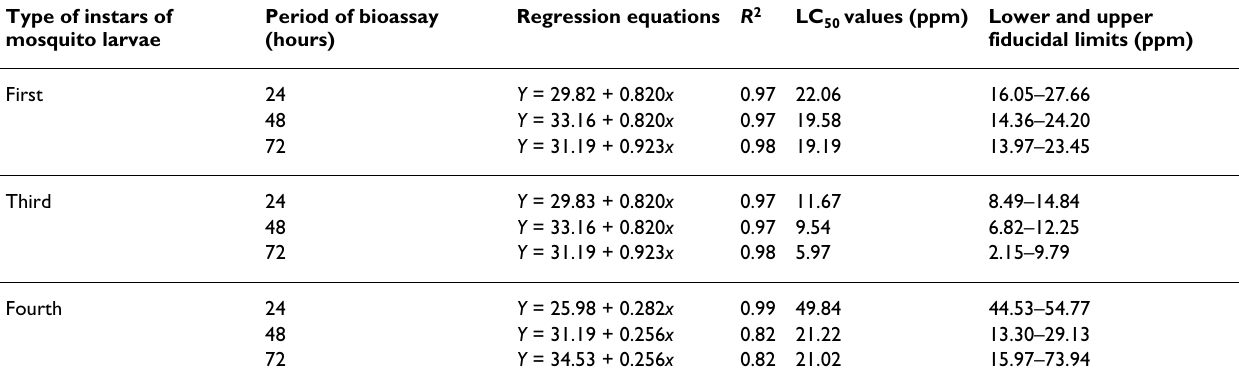
Table 4: Log probit analysis of the larvicidal activity of chloroform:methanol extract of the green berries of S. villosum on different instar larvae of S. aegypti . LC, lethal concentration; R , coefficient of regression equations. Type of instars of Period of bioassay Regression equations R mosquito larvae (hours)